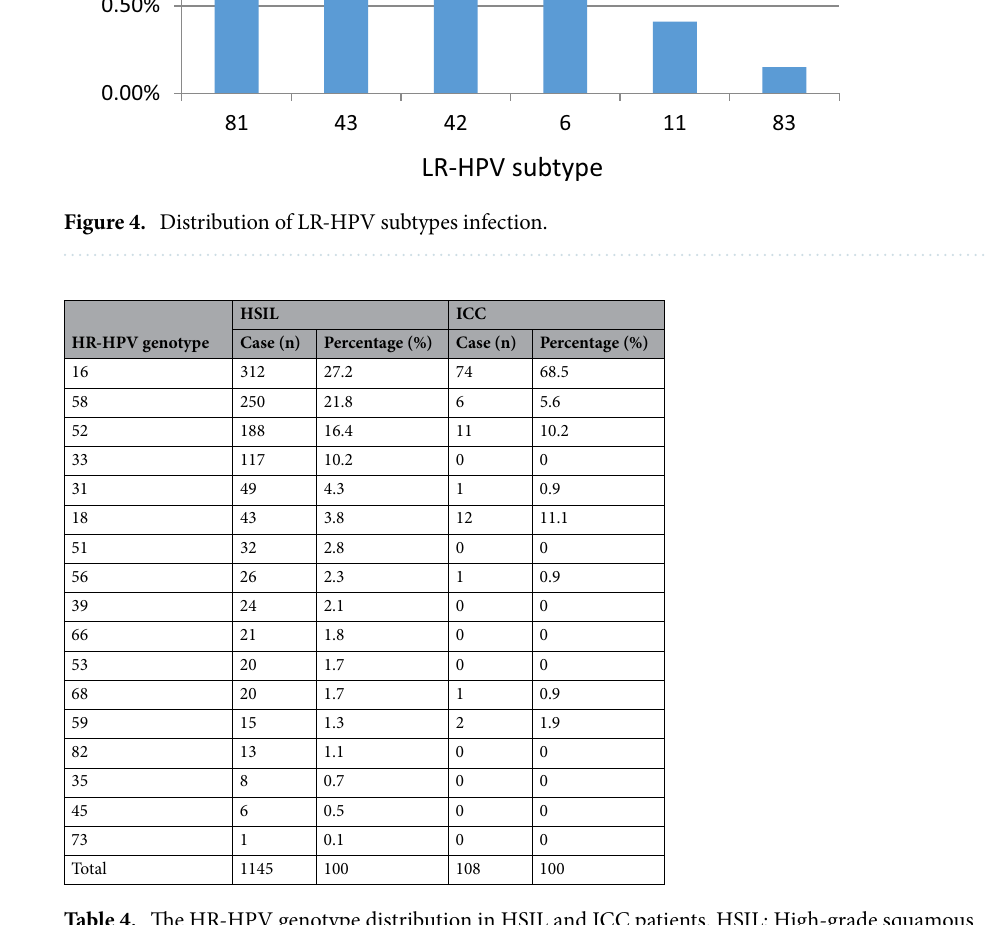
Table 4. The HR-HPV genotype distribution in HSIL and ICC patients. HSIL: High-grade squamous intraepithelial lesion. ICC: Invasive cervical